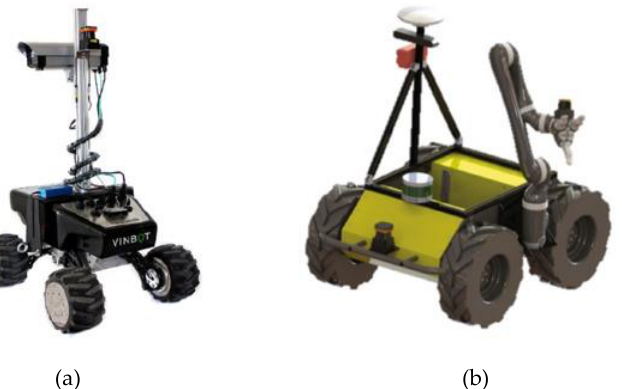
Figure 10. Agbots: ( a ) Vinbot robot platform (reproduced from [73] with permission from Jones, G.; Doran, N., Eds. , 2016); ( b ) GRAPE (GroundRobot for vineyArd Monitoring and ProtEction) (reproduced from [74] with permission from Springer , 2017).